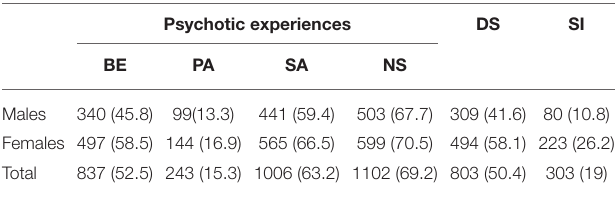
TABLE 2 | Prevalence (%) of psychotic experiences, depressive symptoms, and suicide ideation in the study sample (at least one time, lifetime). Psychotic